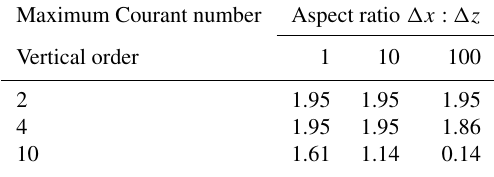
Table 3. Numerically computed estimates of the Courant– Friedrichs–Lewy condition (maximum Courant number) using Thermal bubble tests over a wide range of horizontal:vertical as- pect ratios. The maximum wave speed corresponds to the speed √ γR d T where γ = 1 . 4, R d = 286 . 07, and of sound given by c = T = 300 .